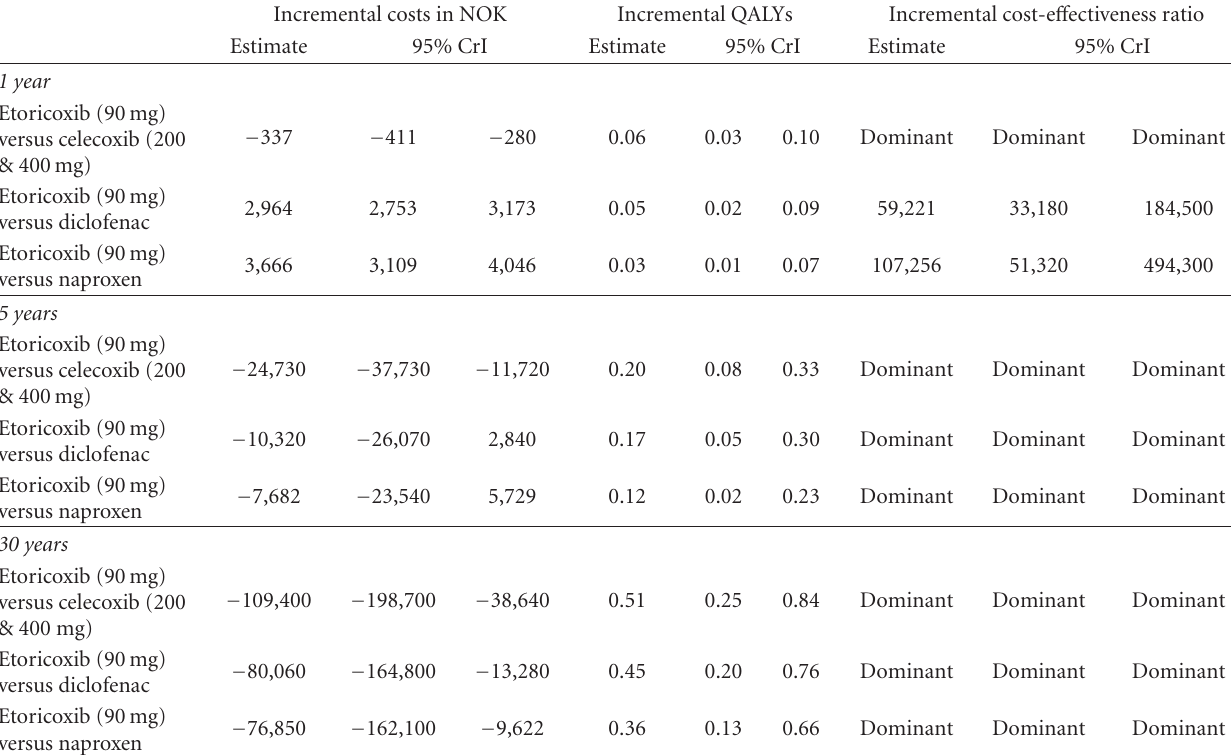
Table 5: Cost-e ff ectiveness of etoricoxib relative to other interventions (base-case scenario). Incremental costs in NOK Incremental QALYs Estimate